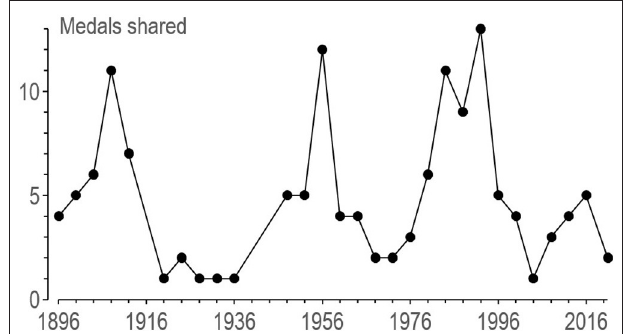
FIGURE 1 | Count of shared medals arising from ties in the Summer Olympics. Data are from Wikipedia (2021). Thirteen three-way ties were each counted as two instances of medal sharing, and one four-way tie was counted as three